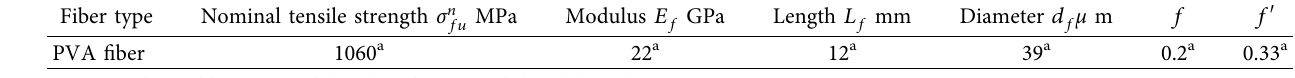
Table 1: Physical properties of PVA fibers.